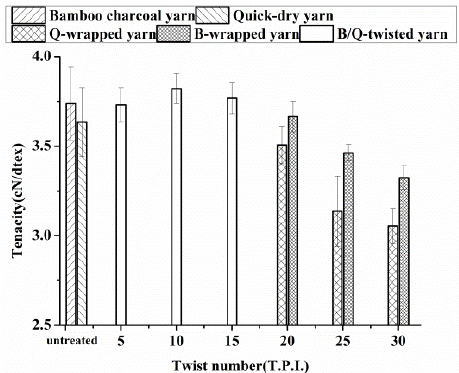
Figure 4. Tenacity of functional composite yarns in relation to the administration of a wrapping/ twisting process as well as the twist number. The error bar indicates the Standard deviation (SD). Q: Quick-dry, and B: Bamboo charcoal.